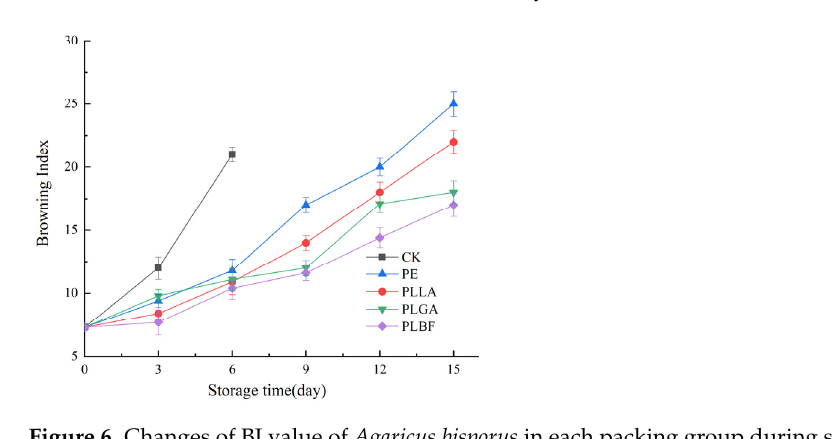
Figure 5. Surface and section images of Agaricus bisporus of CK ( A ) in 0 days and CK ( B-1 ), PE ( B-2 ), PLLA ( B-3 ), PLGA ( B-4 ), and PLBF ( B-5 ) at 15th days.